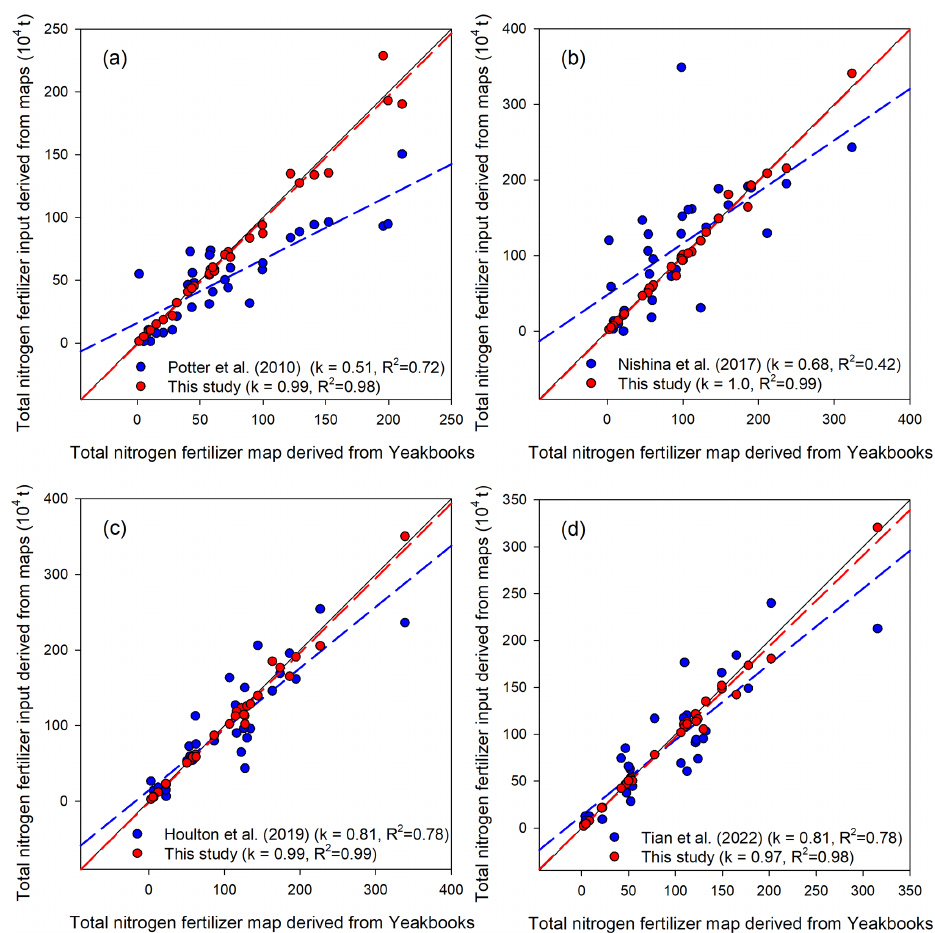
Figure 9. Comparisons of the total nitrogen fertilizer input in each province in China derived from different nitrogen fertilizer data products. The x axes indicate the nitrogen fertilizer input obtained from the Chinese Statistical Yearbook; the black solid line indicates the 1 : 1 line, and the red and blue lines indicate the linear regressions of the provincial nitrogen fertilizer input derived from this study and other studies. Panels (a) – (d) show comparisons in the period/years of 1994–2001, 2010, 2015, and 2018, respectively. Data of other studies were derived from the nitrogen fertilizer maps of Potter et al. (2010), Nishina et al. (2017), Houlton et al. (2019), and Tian et al. (2022),